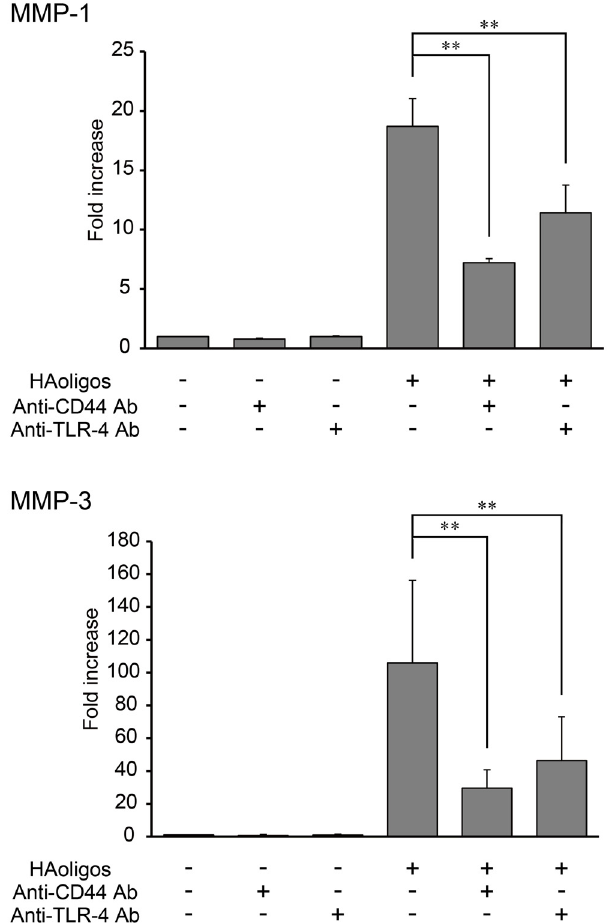
Fig 3. Expression levels of MMP mRNA induced by HAoligo treatment with or without CD44 and Toll- like receptor 4 (TLR-4) neutralizing antibodies. RSFs were pre-treated for one hour with or without 5 μ g/ml anti-CD44 and 5 μ g/ml TLR-4 antibodies and followed by HAoligo treatment (250 μ g/ml) for 24 hours. MMP-1 and MMP-3 expression levels were determined by quantitative real-time RT-PCR. Values are mean ± S.D of three independent experiments analyzed in triplicate, and are expressed as n-fold increase compared to untreated control. ** p < 0.01 vs.